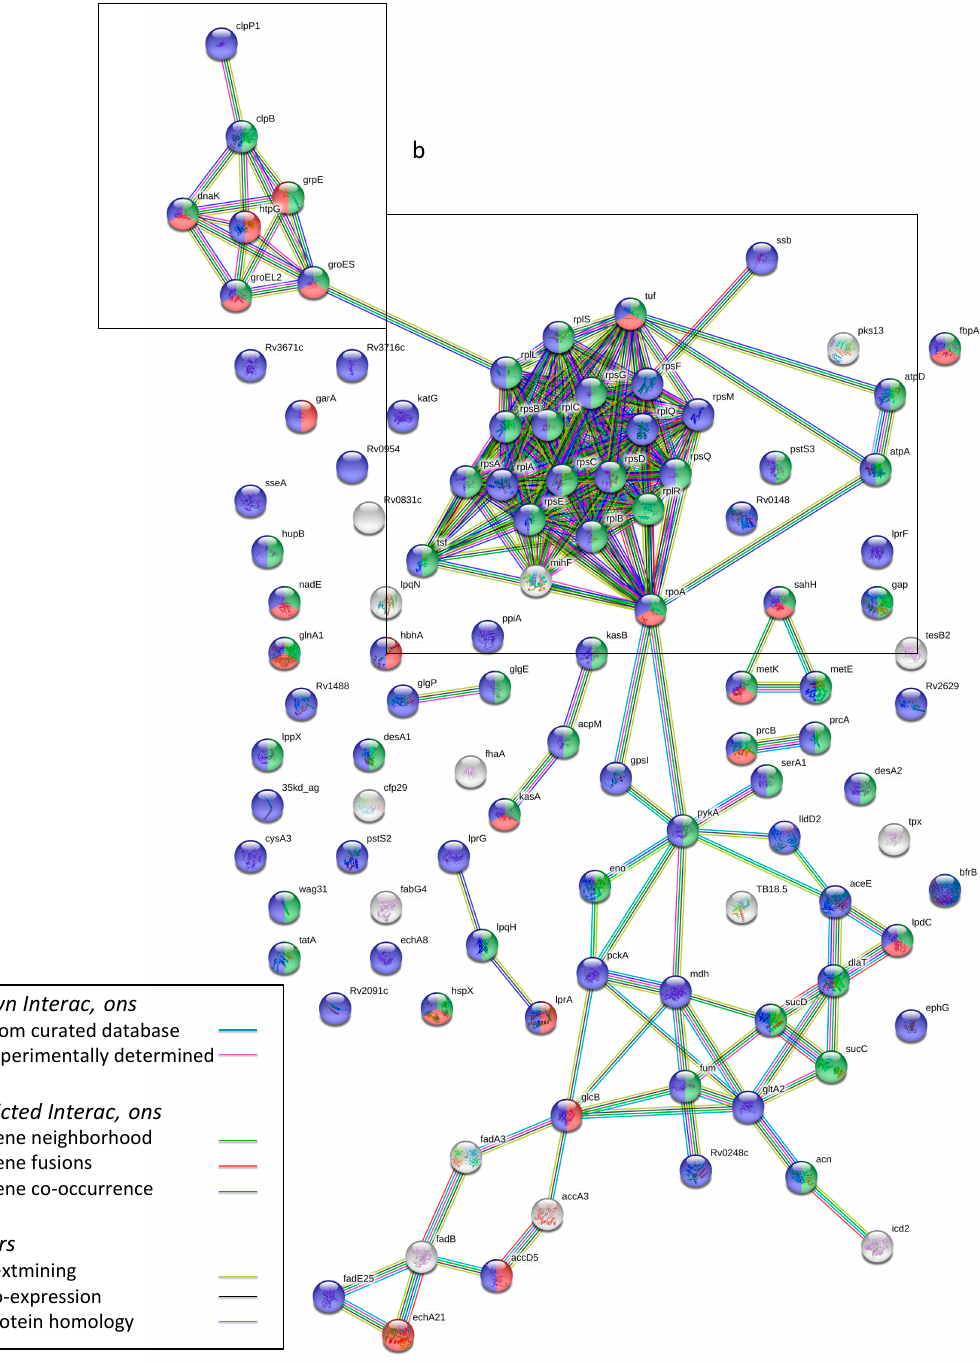
Figure 2. Predictive functional interaction network of 107 shared proteins of A60 and EV MTB using STRING 11.0, showing statistically significant functional interaction networks ( p -value: <1.06 × 10 − 16 ) at minimum interaction score of 0.9. Boxes show ( a ) cluster of chaperone proteins and ( b ) cluster of ribosomal proteins. Node colors indicate functional enrichments based on GO:0040007 growth (green), GO:0005515 protein binding (red), and GO:0005886 plasma membrane (purple). EV MTB protein list was obtained from Lee et al., 2015 [37] (ProteomeXchange PXD001160).